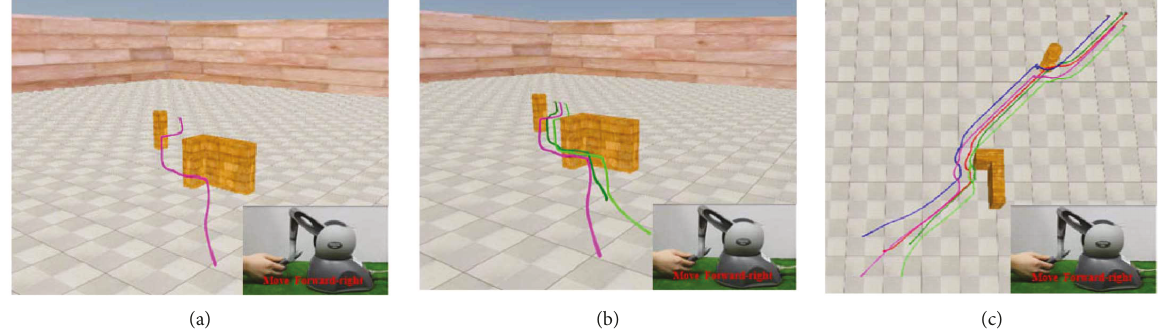
Figure 24: 3D Graphs of the experimental tests. (a) One UAV in the left view. (b) Three UAVs in the left view. (c) Five UAVs in the top view.